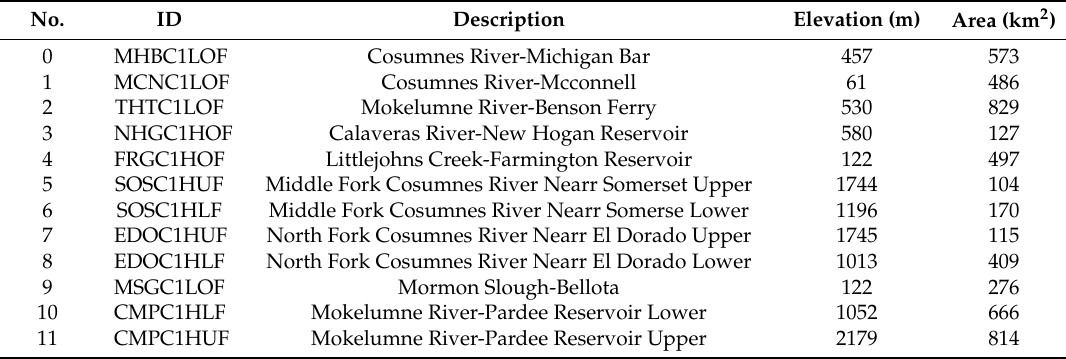
Table A4. Study basins in the North San Joaquin Group.